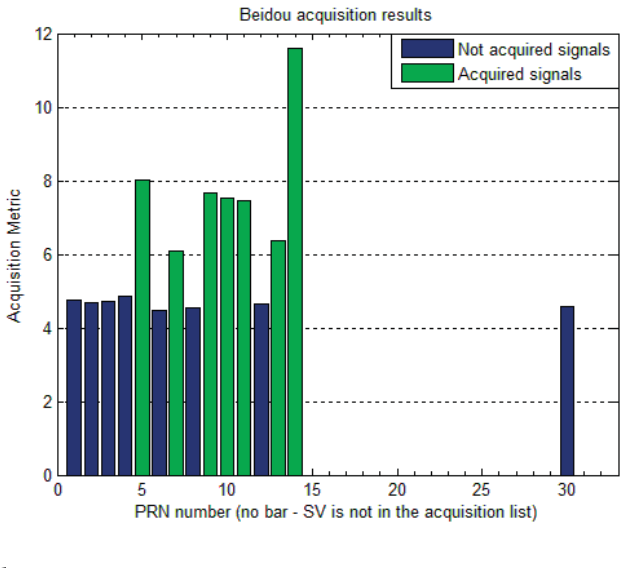
Figure 4. Acquisition metric for BeiDou GEO, IGSO and MEO